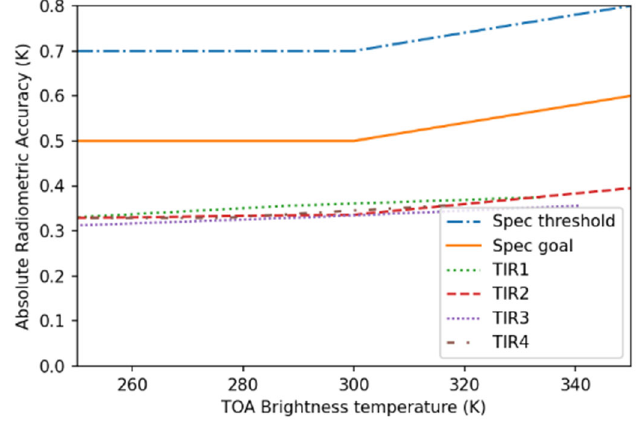
Figure 2. Absolute radiometric accuracy (ARA) for all bands and comparison with the specifications, as a function of TOA brightness temperature.